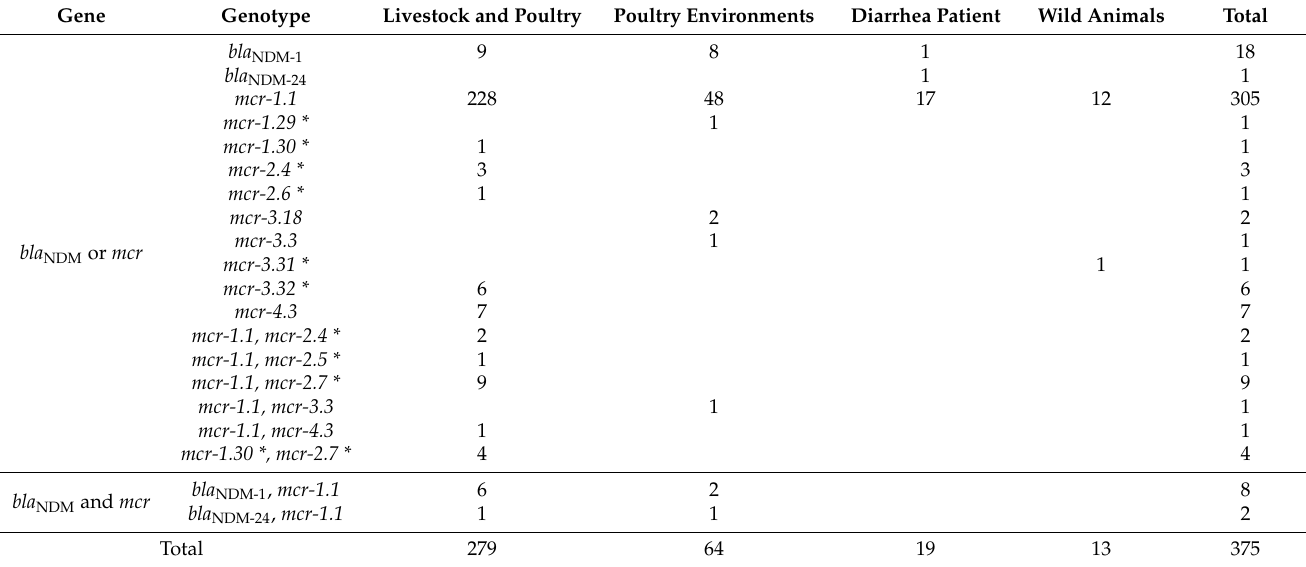
Table 2. Distribution of genotypes and coexisting